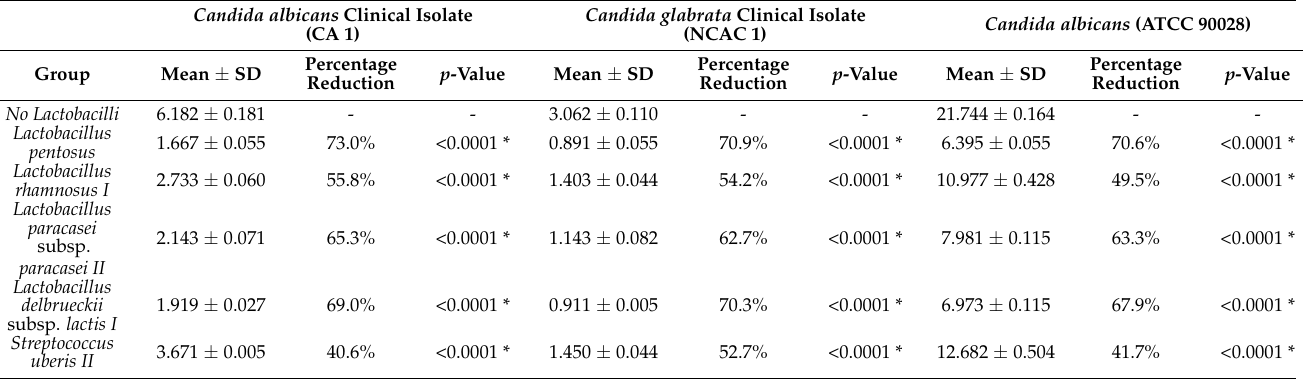
Table 4. Biofilm-inhibitory activity of bacteriocin-like inhibitory substances (BLISs) of potential probiotics against C. albicans and C. glabrata clinical isolates and C. albicans ATCC 90028.